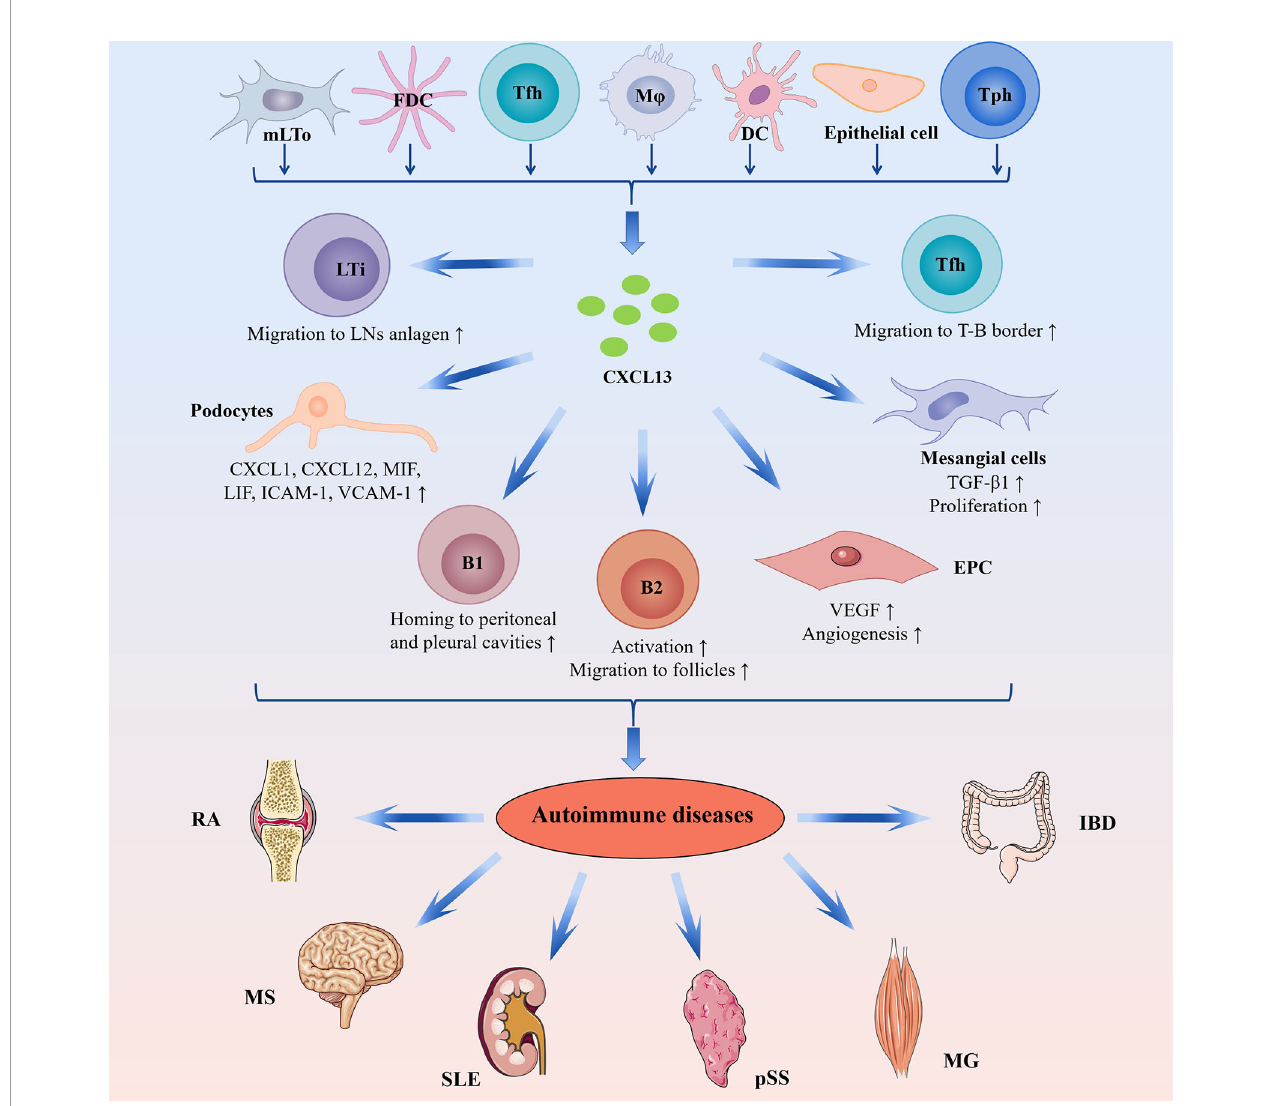
FIGURE 2 | The complicated role of CXCL13-mediated immune responses in autoimmune diseases. CXCL13 can be produced by mLTo cells, FDC, Tfh cells, macrophages, DCs, epithelial cells, and Tph cells. In the fetal stage, CXCL13 promotes migration of LTi cells toward the parenchyma of the LNs anlagen, where LTi cells interact with mLTo cells to induce lymphoid neogenesis. CXCL13 is involved in the lymphoid organization by attracting B cells toward B-cell follicles. During an immune response, CXCL13 attracts B cells toward the light zones of GCs, where B cells undergo af fi nity selection and become long-lived plasma cells or memory B cells. Furthermore, CXCL13-mediated Tfh cells migration is essential in facilitating GCs response. In addition, CXCL13/CXCR5 axis is also implicated in B1 cell response through attracting B1 cell toward the body cavity. In autoimmune diseases, ectopic CXCL13 expression promotes ectopic lymphoid neogenesis and the production of disease-speci fi c autoantibodies. In RA, CXCL13 drives EPC homing and VEGF expression, thus inducing angiogenesis in synovial tissue. In LN, CXCL13 promotes proliferation and TGF- b 1 production of mesangial cells and induces podocyte secretion of proin fl ammatory cytokines/chemokines such as CXCL1, CXCL12, MIF, LIF, and soluble ICAM-1 and VCAM-1. DCs, dendritic cells; EPC, endothelial progenitor cells; FDC, follicular dendritic cells; GCs, germinal centers; IBD, in fl ammatory bowel disease; ICAM-1, intercellular adhesion molecule 1; LN, lupus nephritis; LIF, leucocyte inhibitory factor; LTi, lymphoid tissue inducer; MG, myasthenia gravis; MIF, macrophage inhibitory factor; mLTo, mesenchymal lymphoid tissue organizer; MS, multiple sclerosis; pSS, primary Sjögren ’ s syndrome; RA, rheumatoid arthritis; SLE, systemic lupus erythematosus; Tfh, T follicular helper; TGF- b 1, transforming growth factor b 1; Tph, T peripheral helper; VCAM-1, vascular cell adhesion molecule 1; VEGF, vascular endothelial growth